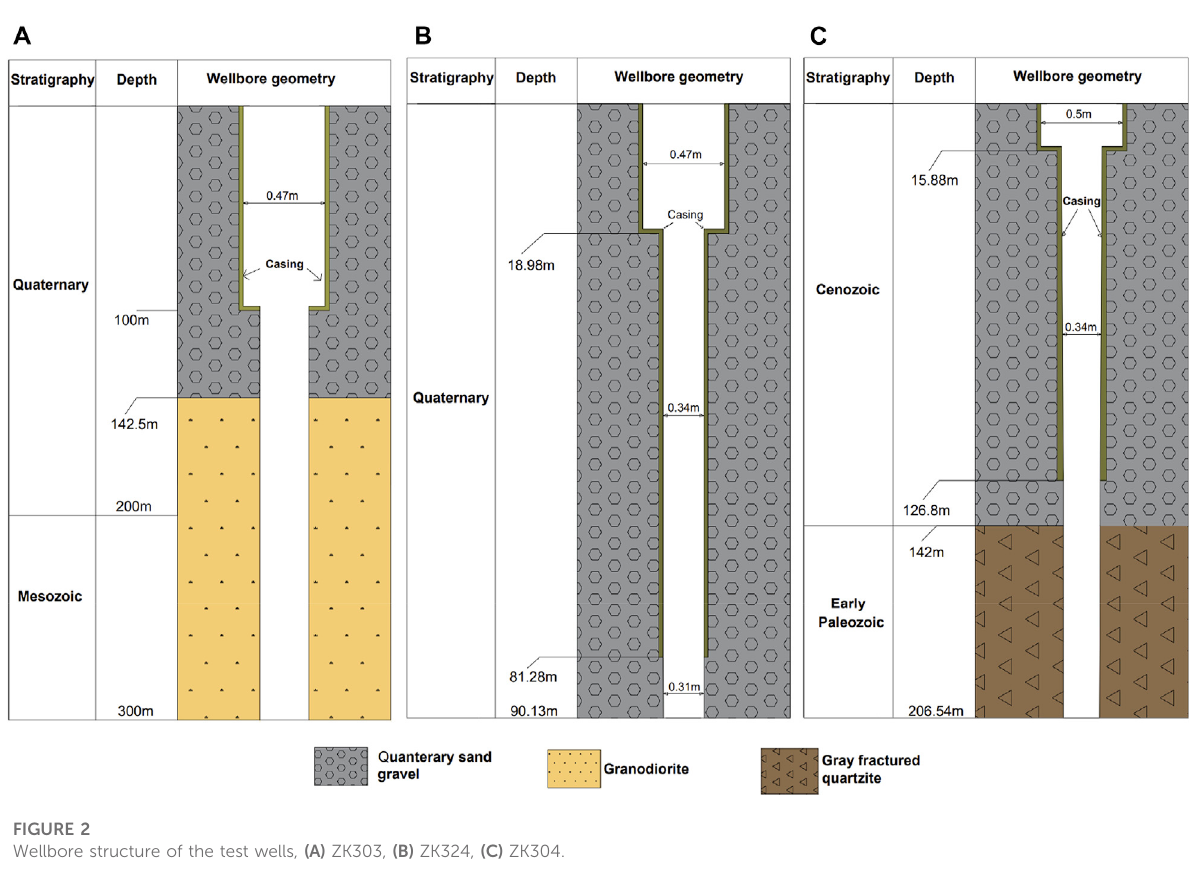
FIGURE 2 Wellbore structure of the test wells, (A) ZK303, (B) ZK324, (C)